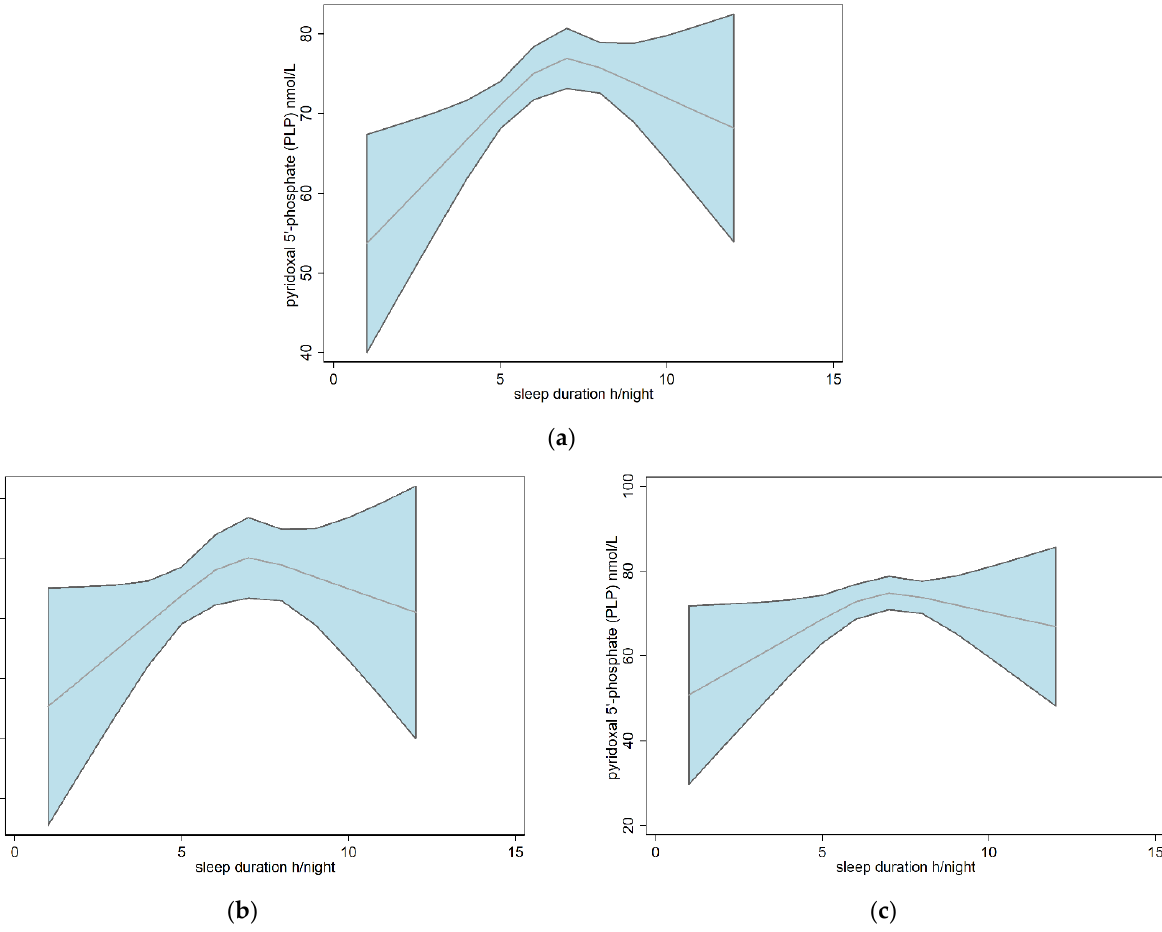
Figure 3. Dose–response relationships between sleep duration and pyridoxal 5 ′ -phosphate (PLP) based on restricted cubic spline models for the overall population ( a ), males ( b ), and females ( c ). The red line and blue area represent the average concentration of PLP and the 95% confidence interval.